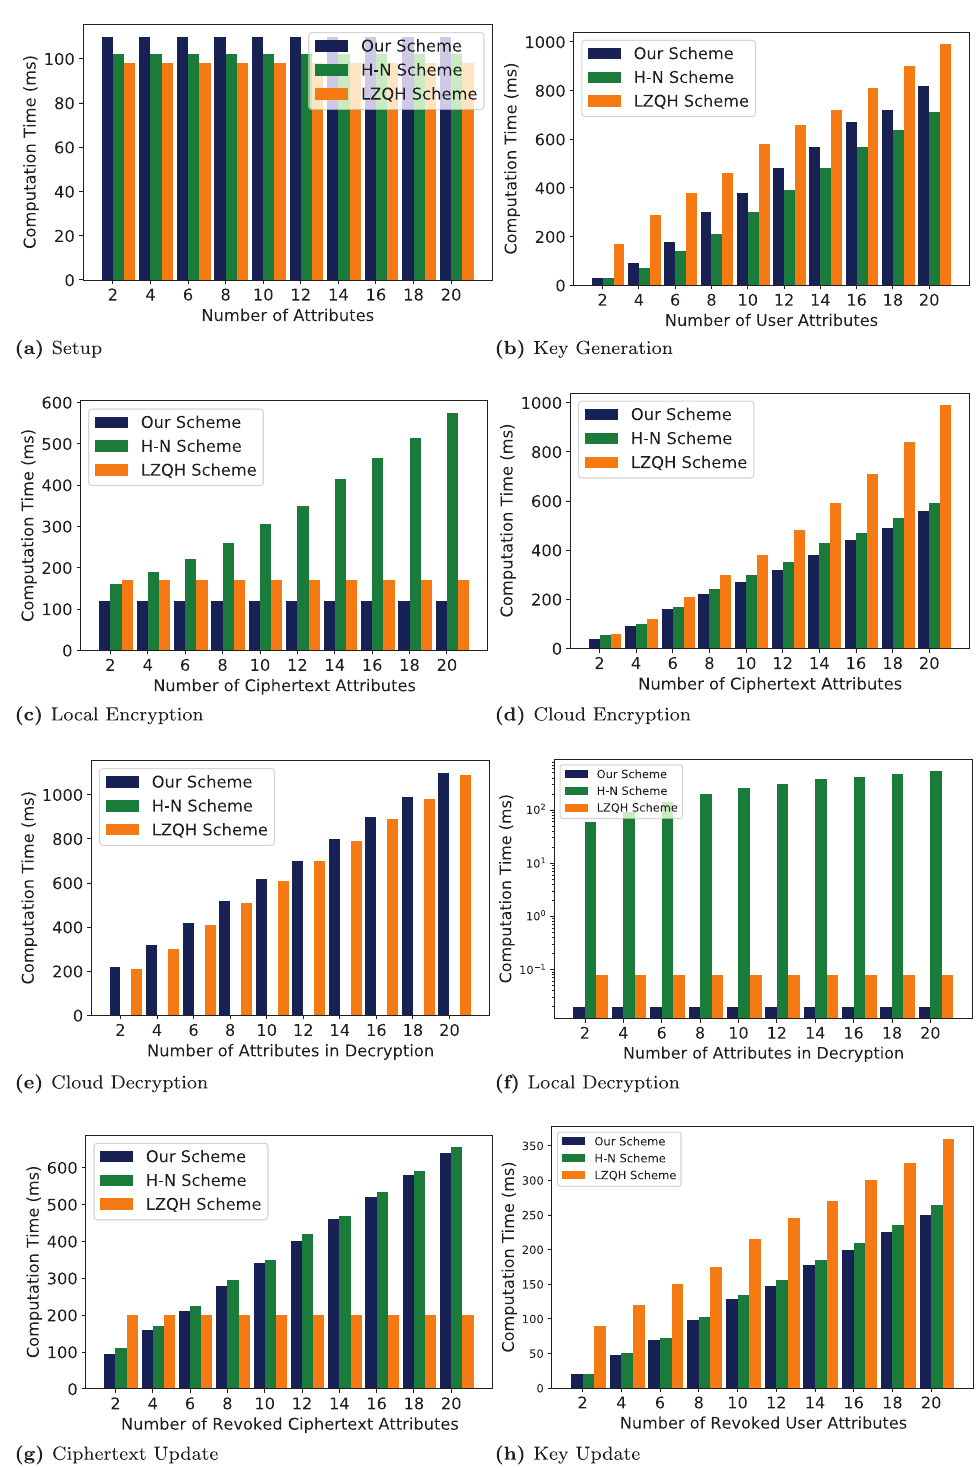
Fig 4. Simulation results of the CESCR scheme in comparison with the LZQH [25] and H-N [24] schemes.